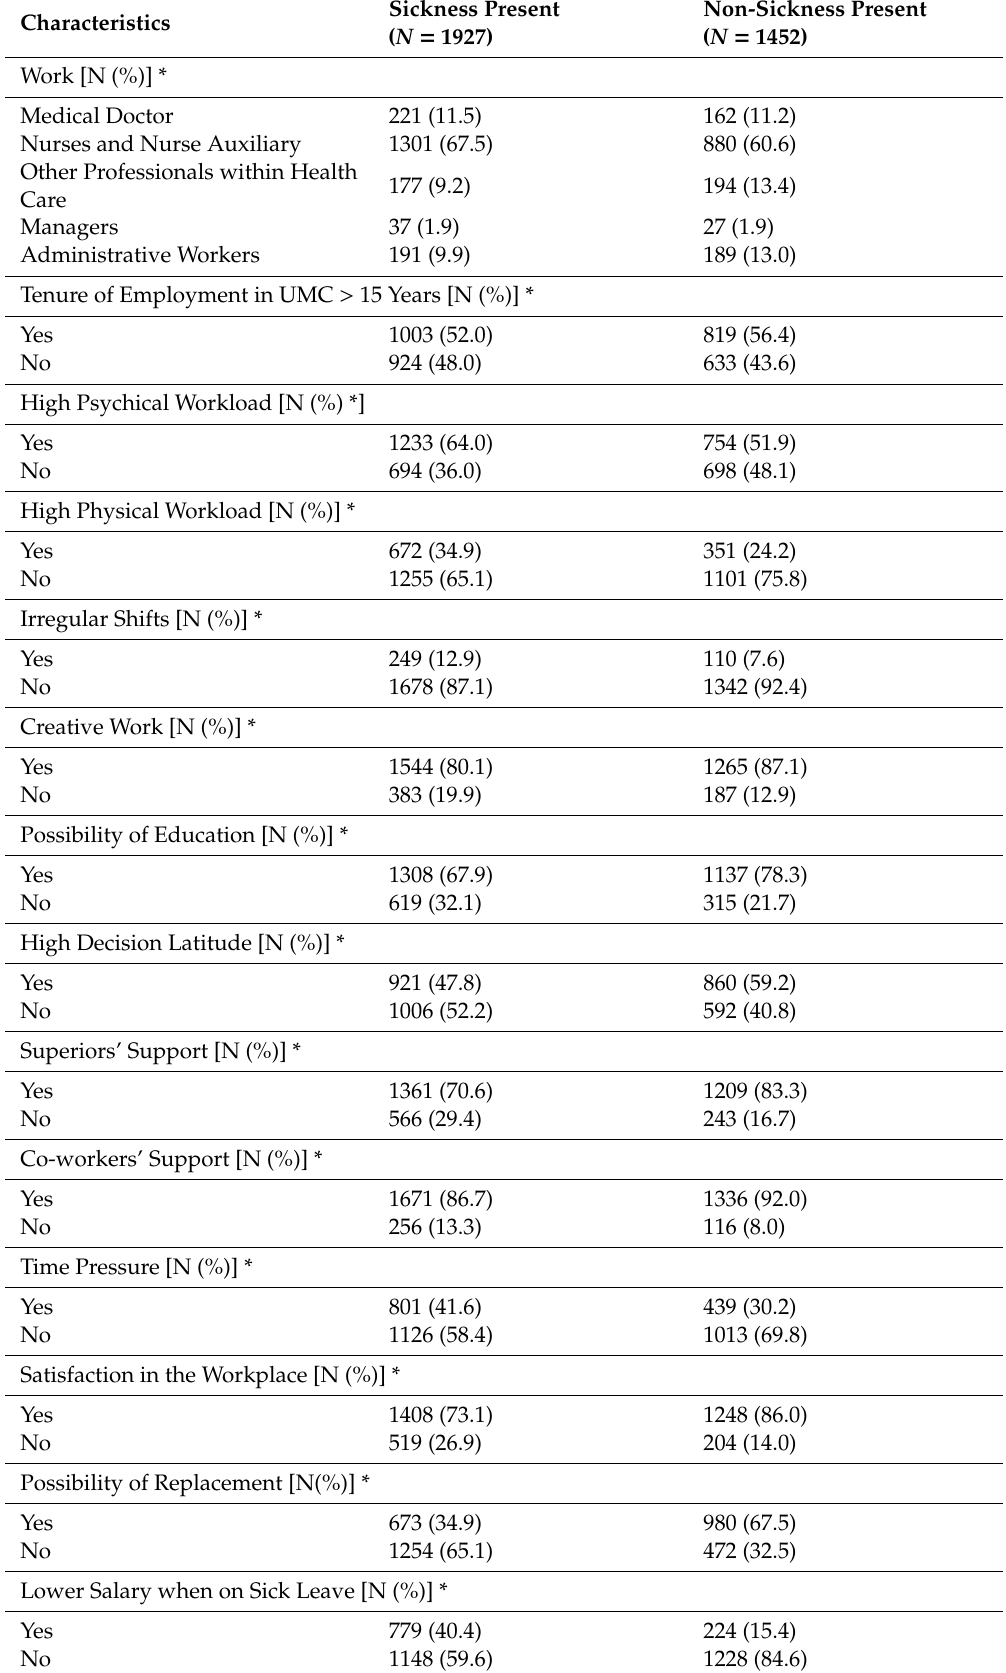
Table 2. Work-related and psychosocial characteristics of the study